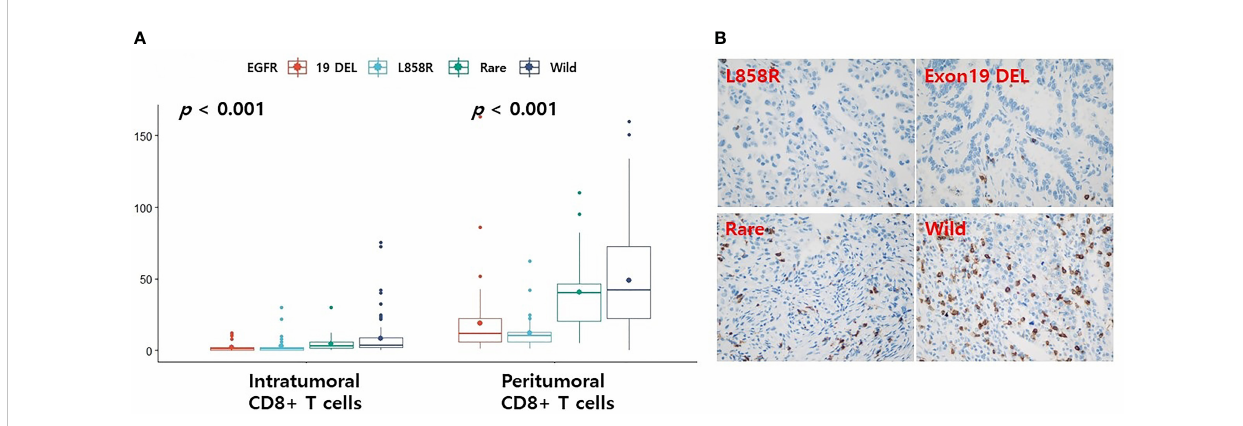
FIGURE 4 Differences in the levels of CD8 according to EGFR mutational subtypes analyzed by immunohistochemistry. (A) Changes in levels of CD8 according to EGFR mutational subtypes. Representative immunohistochemical images of CD8 expression. (B) Case with EGFR L858R or exon 19 deletion mutation is associated with low CD8+ T cells. Case with EGFR rare variant or wild-type is associated with high CD8+ T cells. The small dot in the boxplot is the mean value. 19 DEL, exon 19